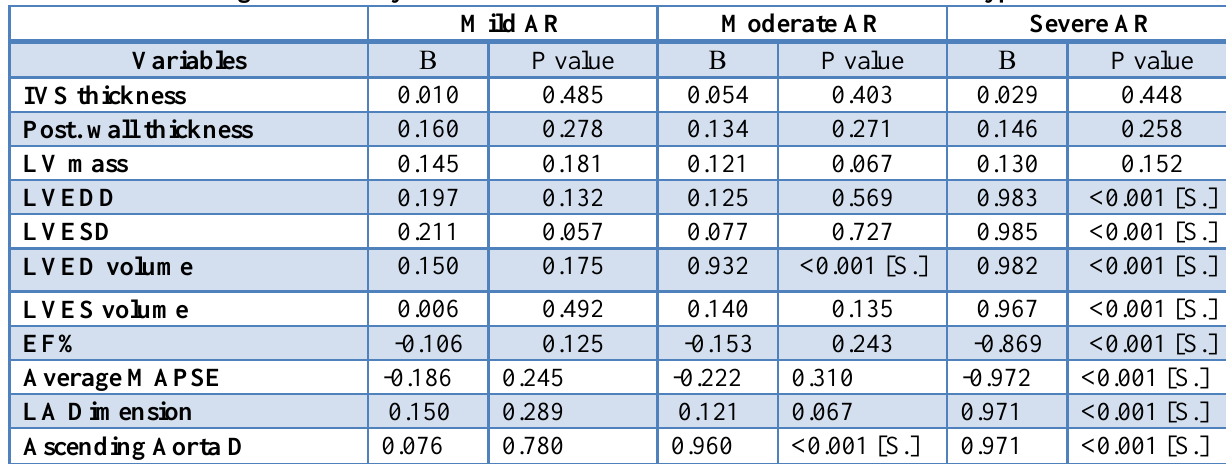
Table 4: Linear regression analysis of different variables versus GLS in different types of